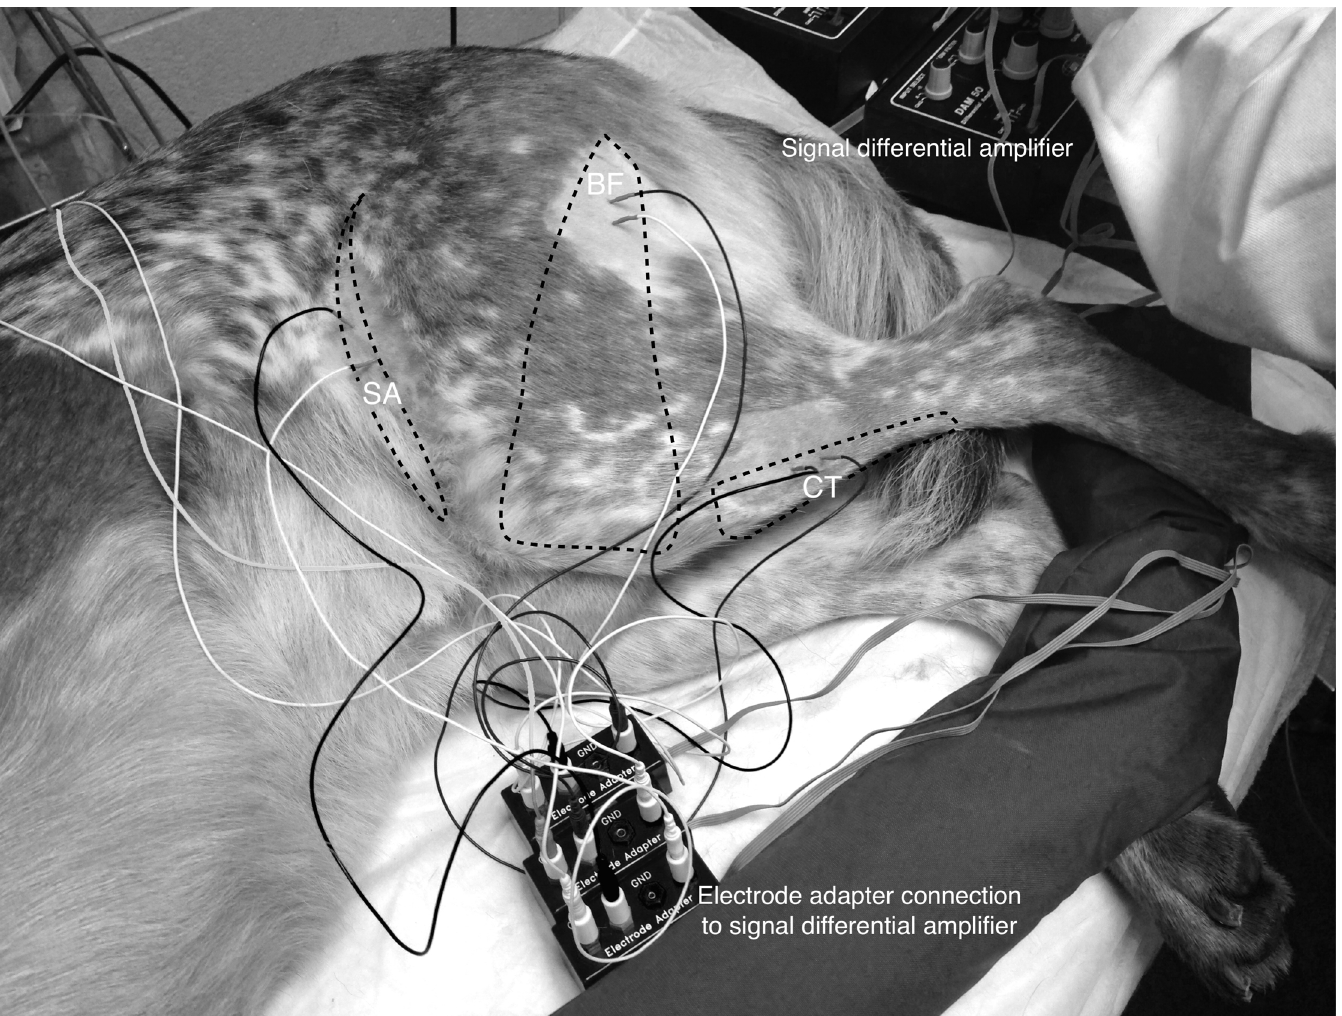
Fig 1. Demonstrating the position of recording electrodes in cranial tibial (CT), biceps femoris (BF) and sartorius (SA) muscles, together with ground electrode placement subcutaneously over the dorsal lumbar